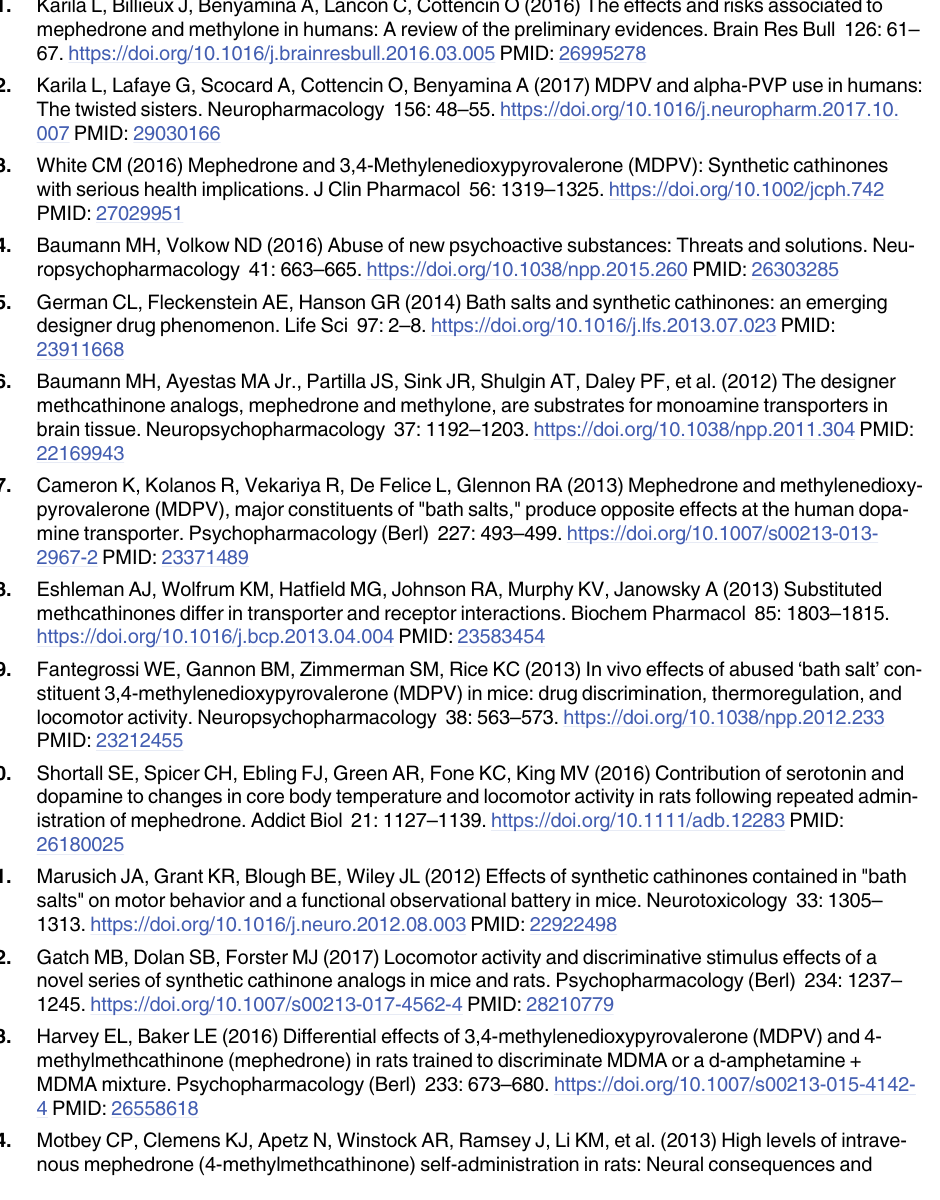
S3 Table. Statistical comparisons for data in Fig 5 and S3 Fig. Cell entries are p values for the indicated statistical comparisons among controls and drug treatments. The symbols are